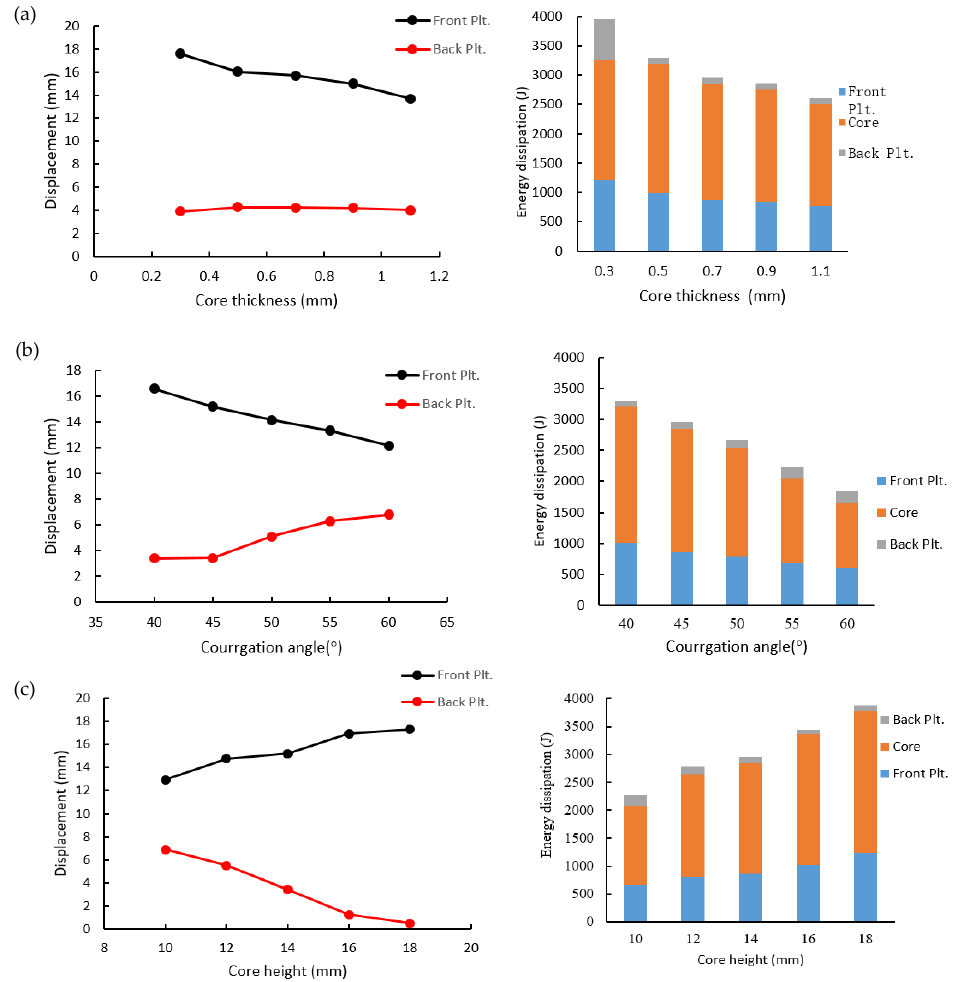
Figure 12. Facing sheets mid-span deflection and energy dissipation For RCSP components with variation in ( a ) core thickness, ( b ) the angle of corrugation and ( c ) core height .